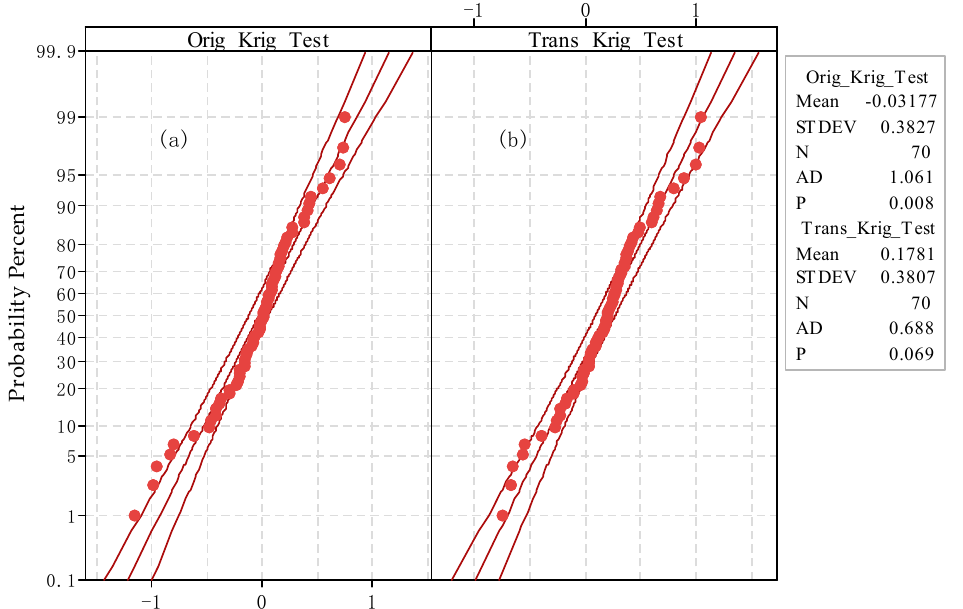
Figure 4. A–D tests of original and transformed difference data in the kriging model: ( a ) original and ( b ) transformed difference data.